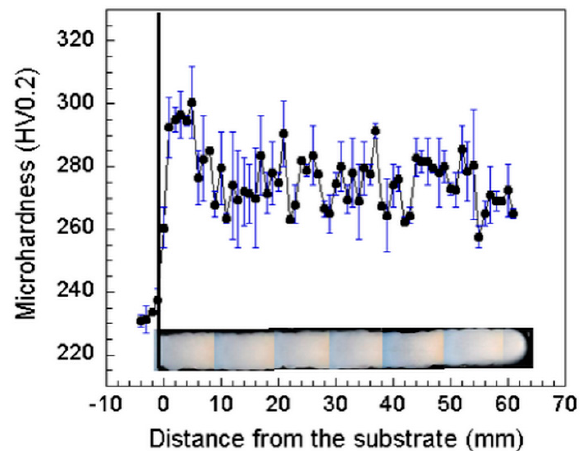
Figure 9. Microhardness along the longitudinal direction for the cross section.